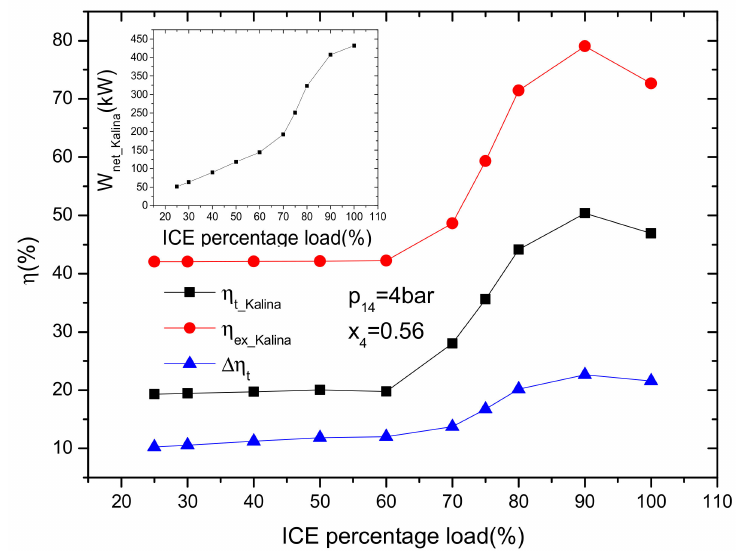
Figure 6. Maximum η t_Kalina , η t , ∆ η t and η ex_Kalina at different ICE percentage